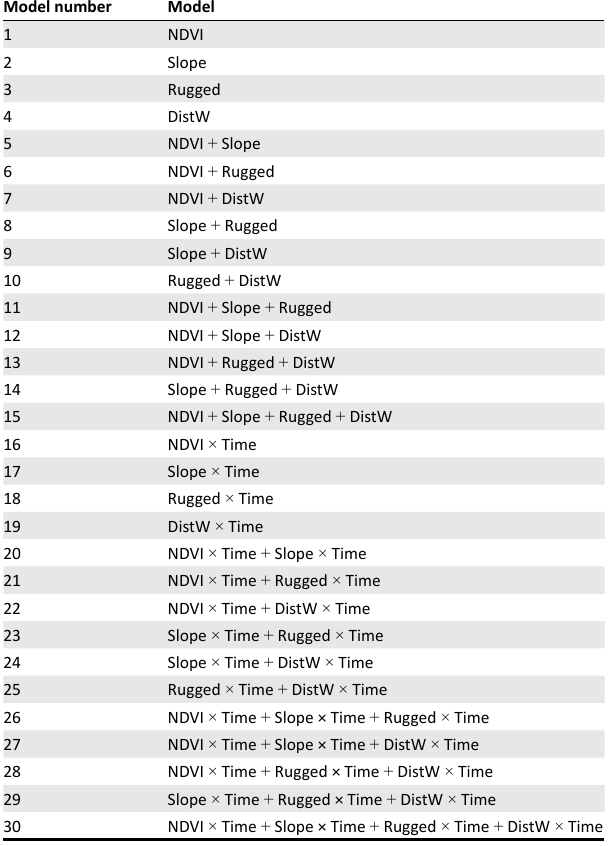
TABLE 1: Candidate models for elephant resource selection in Addo Elephant National Park, South Africa. Model